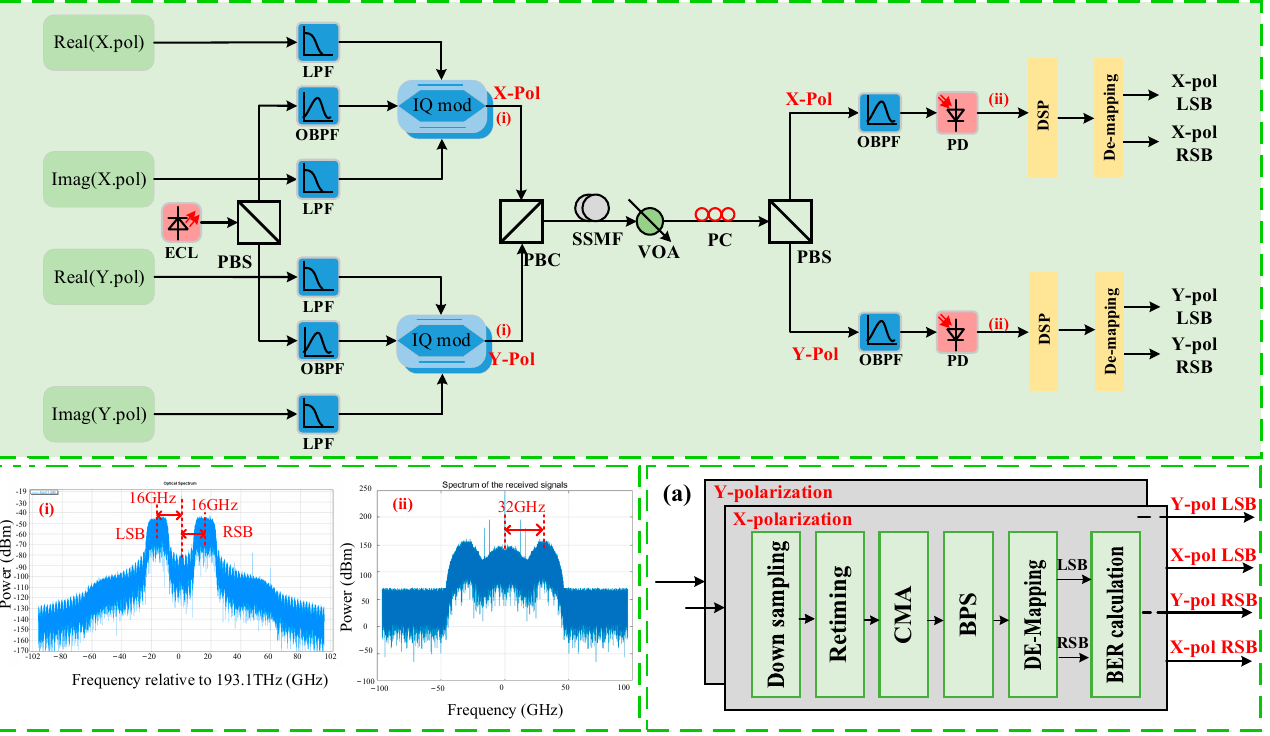
Figure 2. Simulation setup and DSP of the simplified PDM Twin-SSB system; inset ( i ): Optical spectra of Twin-SSB signal after IQM; inset ( ii ): Spectrum of received electrical signal via PD; inset ( a ) DSP diagram of the PDM- Twin-SSB signal at the receiver side. LPF: low-pass filter; PBC: polarization beam combiner; VOA: variable optical attenuator; PC: polarization controller; PBS: polarization beam splitter; OBPF: optical bandpass filter.